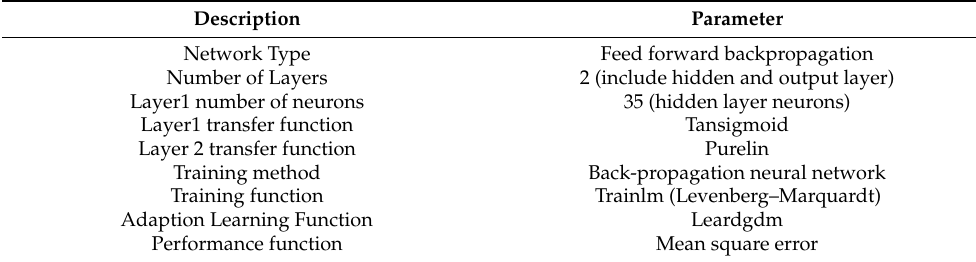
Table 1. Parameters of back-propagation neural network.